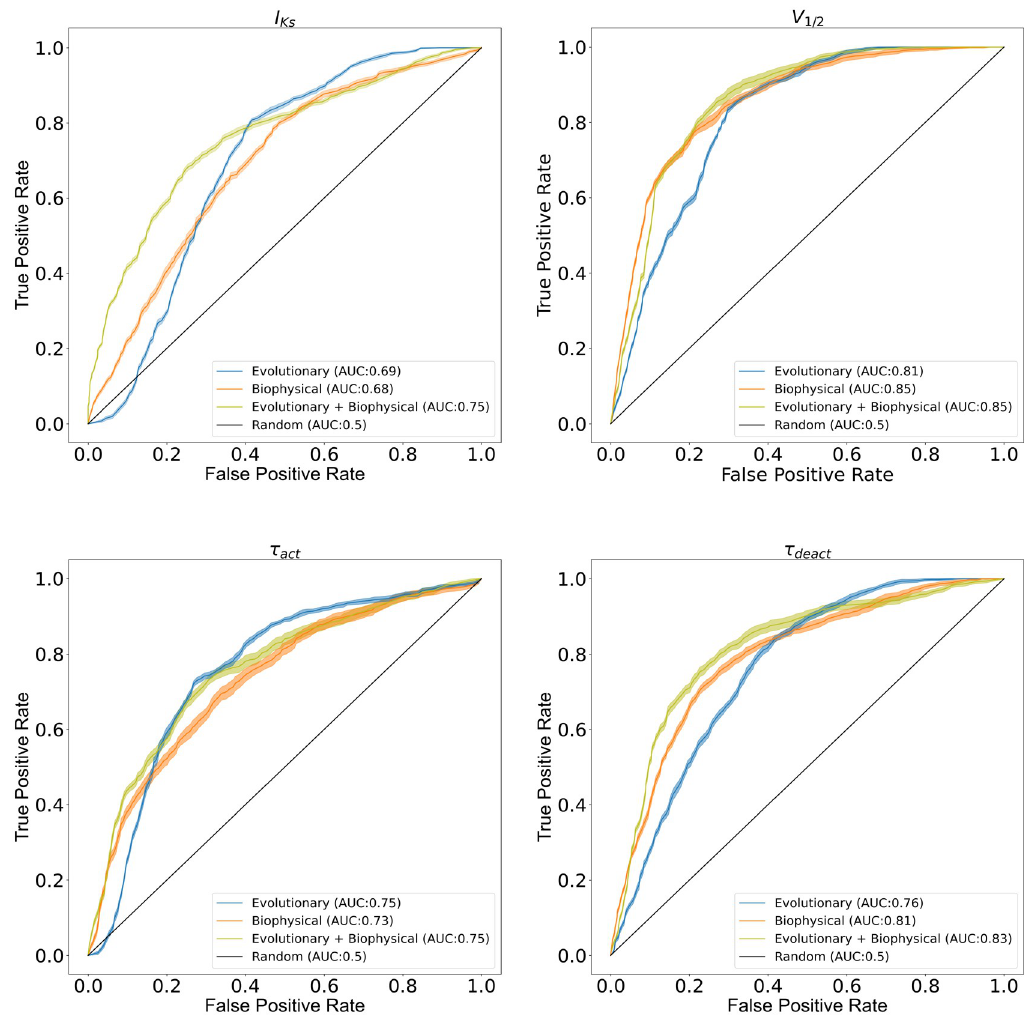
Fig 3. ROC Plots with 99% confidence interval (shaped region) for all-functional parameters of KCNQ1 channel considered in this study. Different color scheme is used to depict performance of the three feature